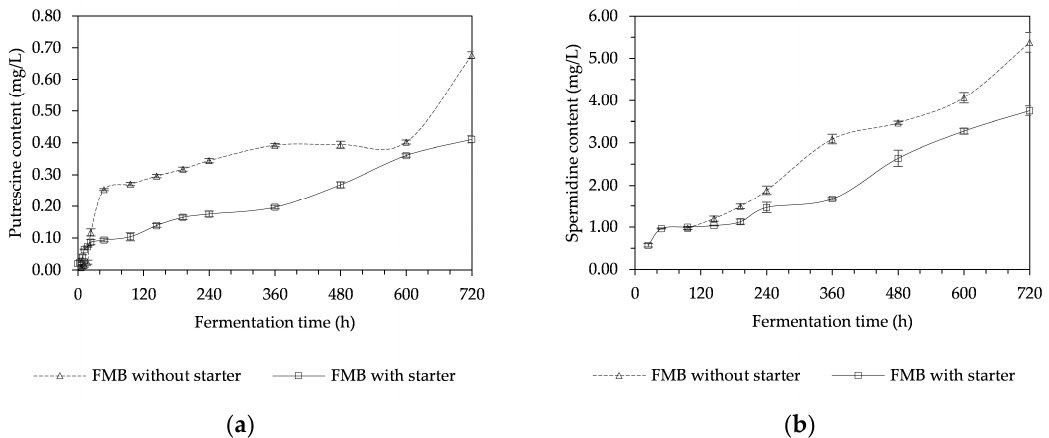
Figure 2. The change of biogenic amines content in a fermented mushroom beverage (FMB) with and without starter culture L. plantarum SK15 during fermentation time: ( a ) putrescine (PUT); ( b ) spermidine (SPD).